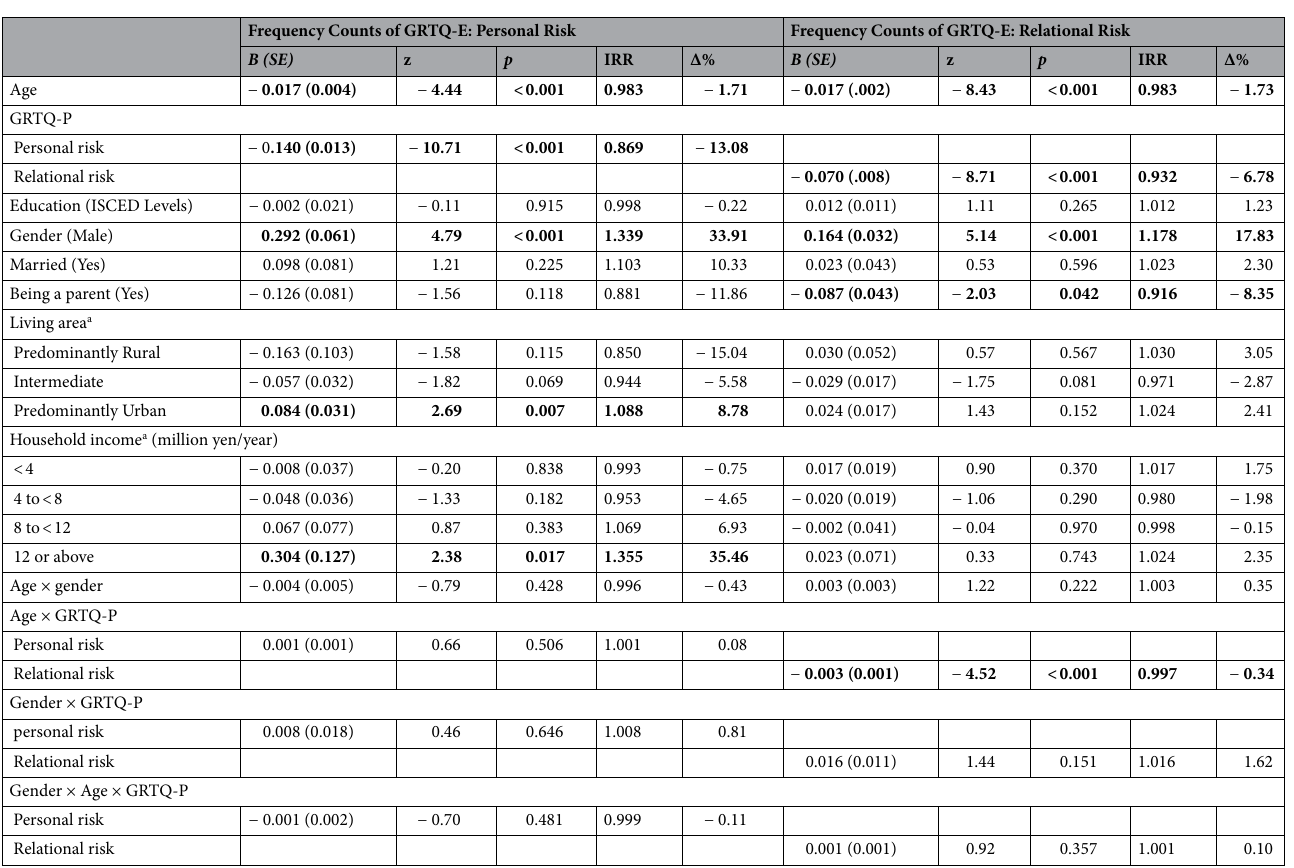
Table 4. Multivariate negative binomial regression model estimates (n = 2984), modeling the GRTQ-E Personal Risk and Relational Risk subscales. B unstandardized regression estimates with standard errors